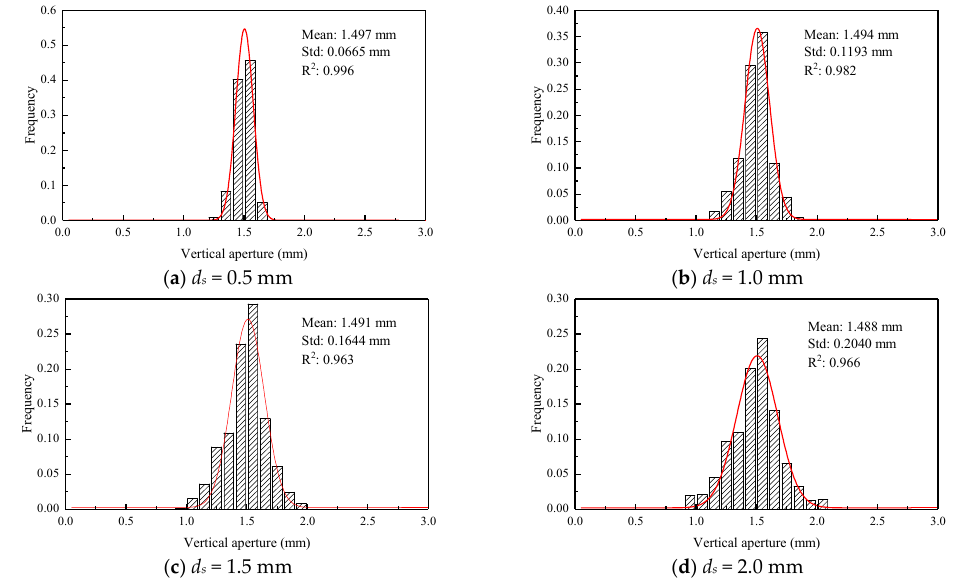
Figure 3. Gaussian distribution and vertical apertures for different shear displacements when JRC = 5.34.